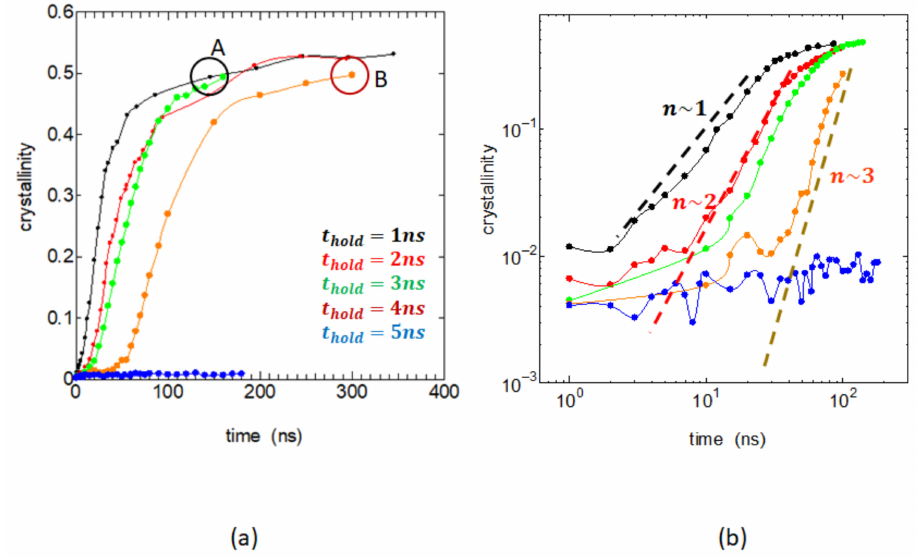
Figure 5. ( a ) The progress of crystallization over longer time scale of several hundred of nanoseconds for five different holding times t hold : 1 ns (black), 2 ns (red), 3 ns (green), 4 ns (orange), and 5 ns (blue). States A and B circled represent two typical states of different crystallization histories, the behavior of deformation of which will be discussed later in Figure 7b. ( b ) The same crystallinity data are plotted in log–log scales, which are the so-called Avrami plots. Considerable changes in the slope of the linear increases are